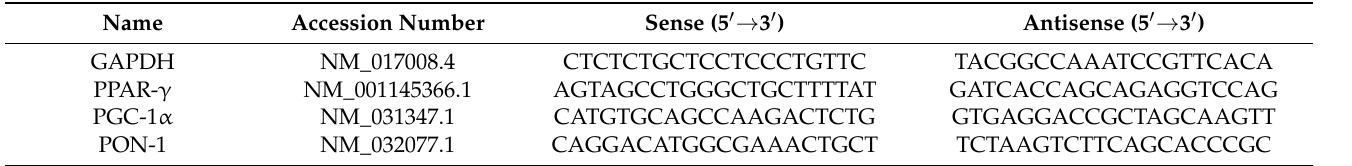
Table 3. Primer sequences of genes analyzed in real-time